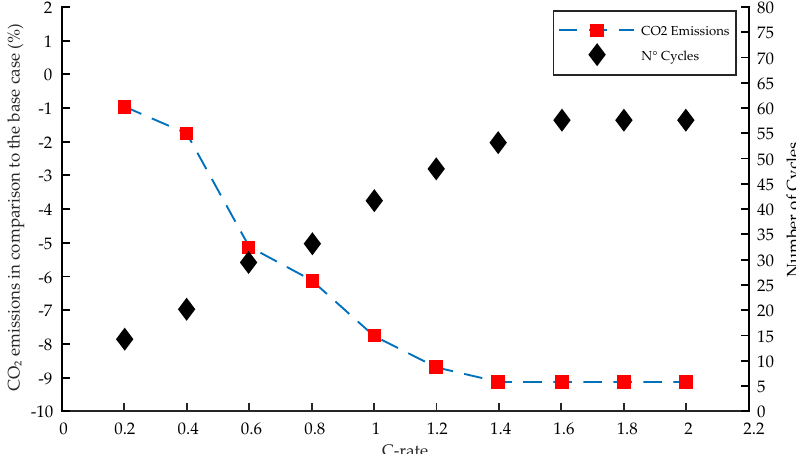
Figure 9. CO 2 emissions reduction in the case of four diesel generators with batteries in comparison to the base case (four diesel generators and no battery). The energy capacity of the battery system is fixed at 1000 kWh and the round trip efficiency at 92%. Multiple cases with C-rates from 0.2 to 2 are